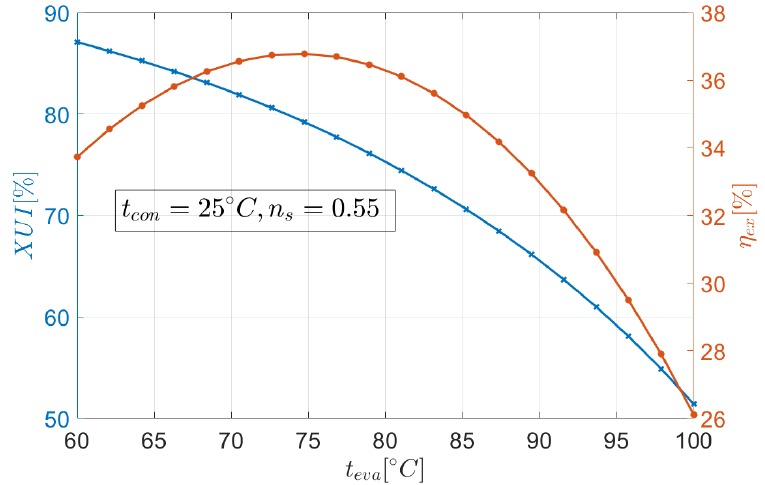
Figure 6. XUI and exergy efficiency η ex as functions of evaporation temperature t eva.